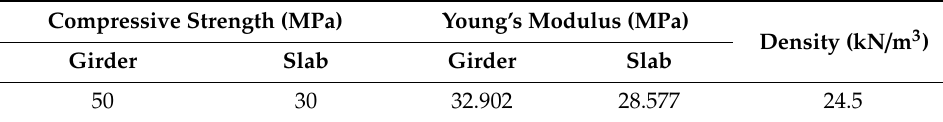
Figure 4. Front view of railway bridge section: ( a ) application of 4 girders for span lengths of 30 m and 35 m; ( b ) application of 5 girders for span lengths of 40 m and 45 m. Table 2. Material properties of concrete.